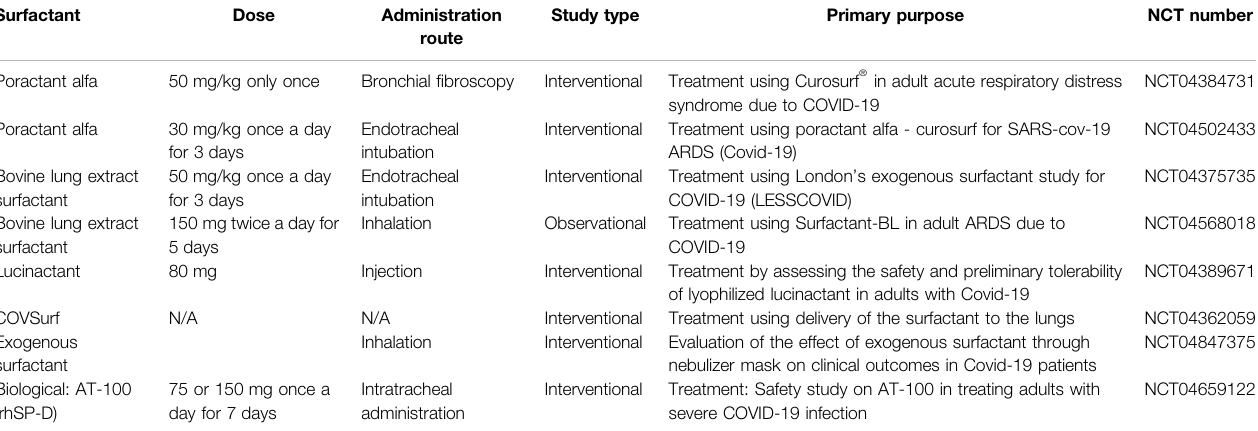
TABLE 2 | Clinical trials on pulmonary surfactants for the treatment of ARDS in COVID-19 patients. Surfactant Dose Administration